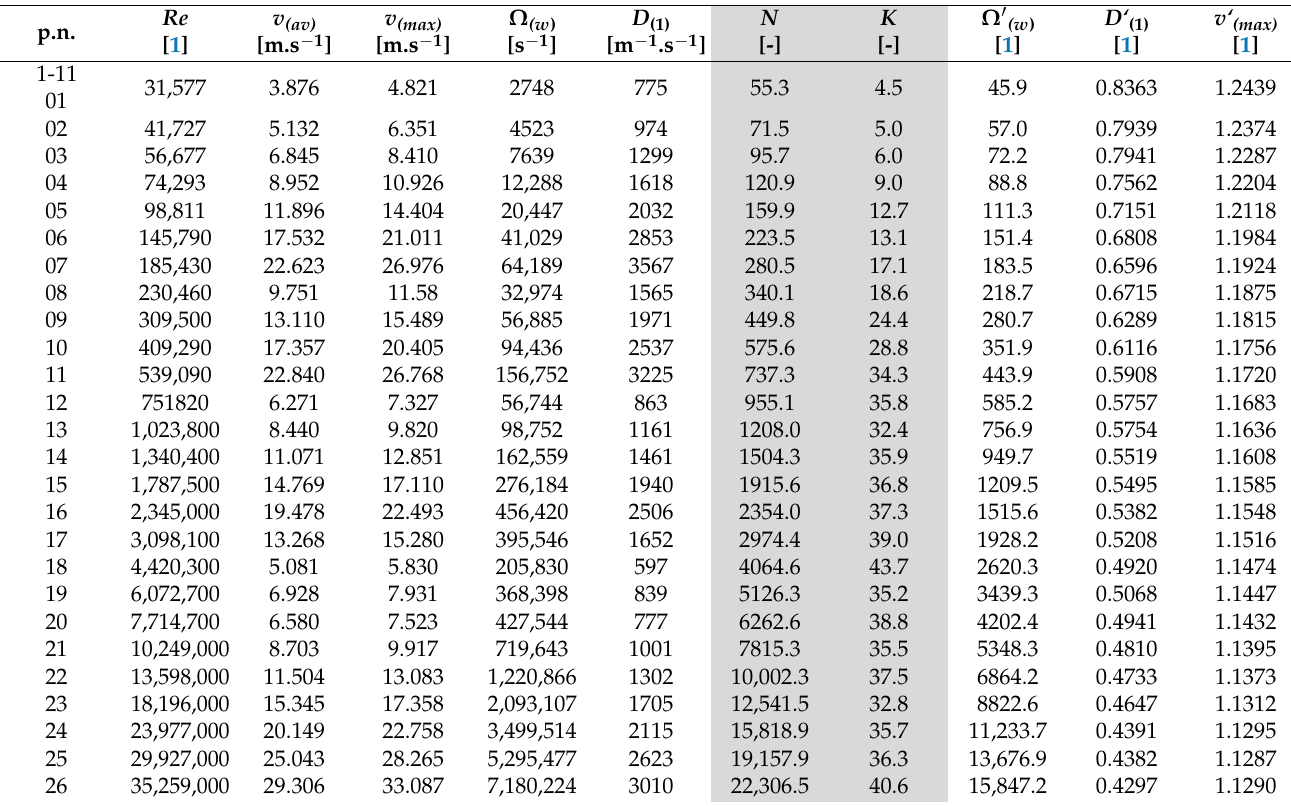
Table 1. Parameters of the analytical velocity profile. Exponents K and N are obtained from comparison with the experimental data. p.n.